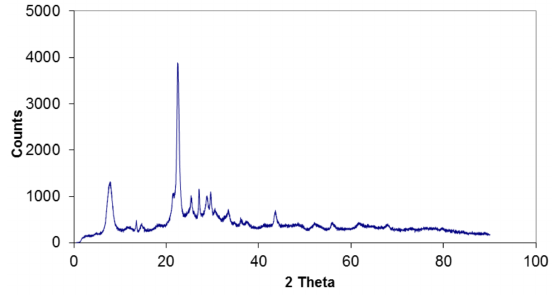
Figure 1. X-ray powder diffraction pattern of H-Beta-25 zeolite.